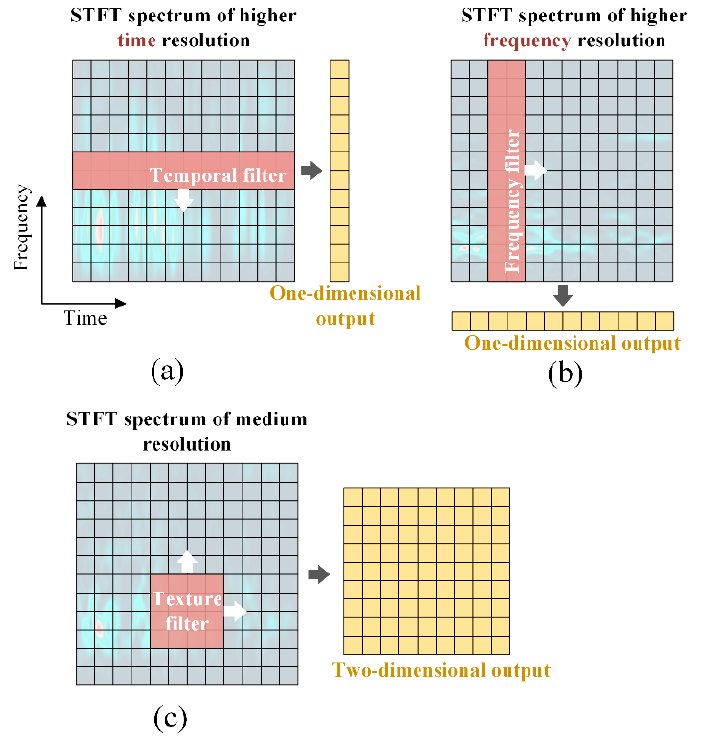
Figure 3. Schematic diagram of the different convolutional filters and their corresponding outputs: ( a ) temporal filter; ( b ) frequency filter; ( c ) texture filter.